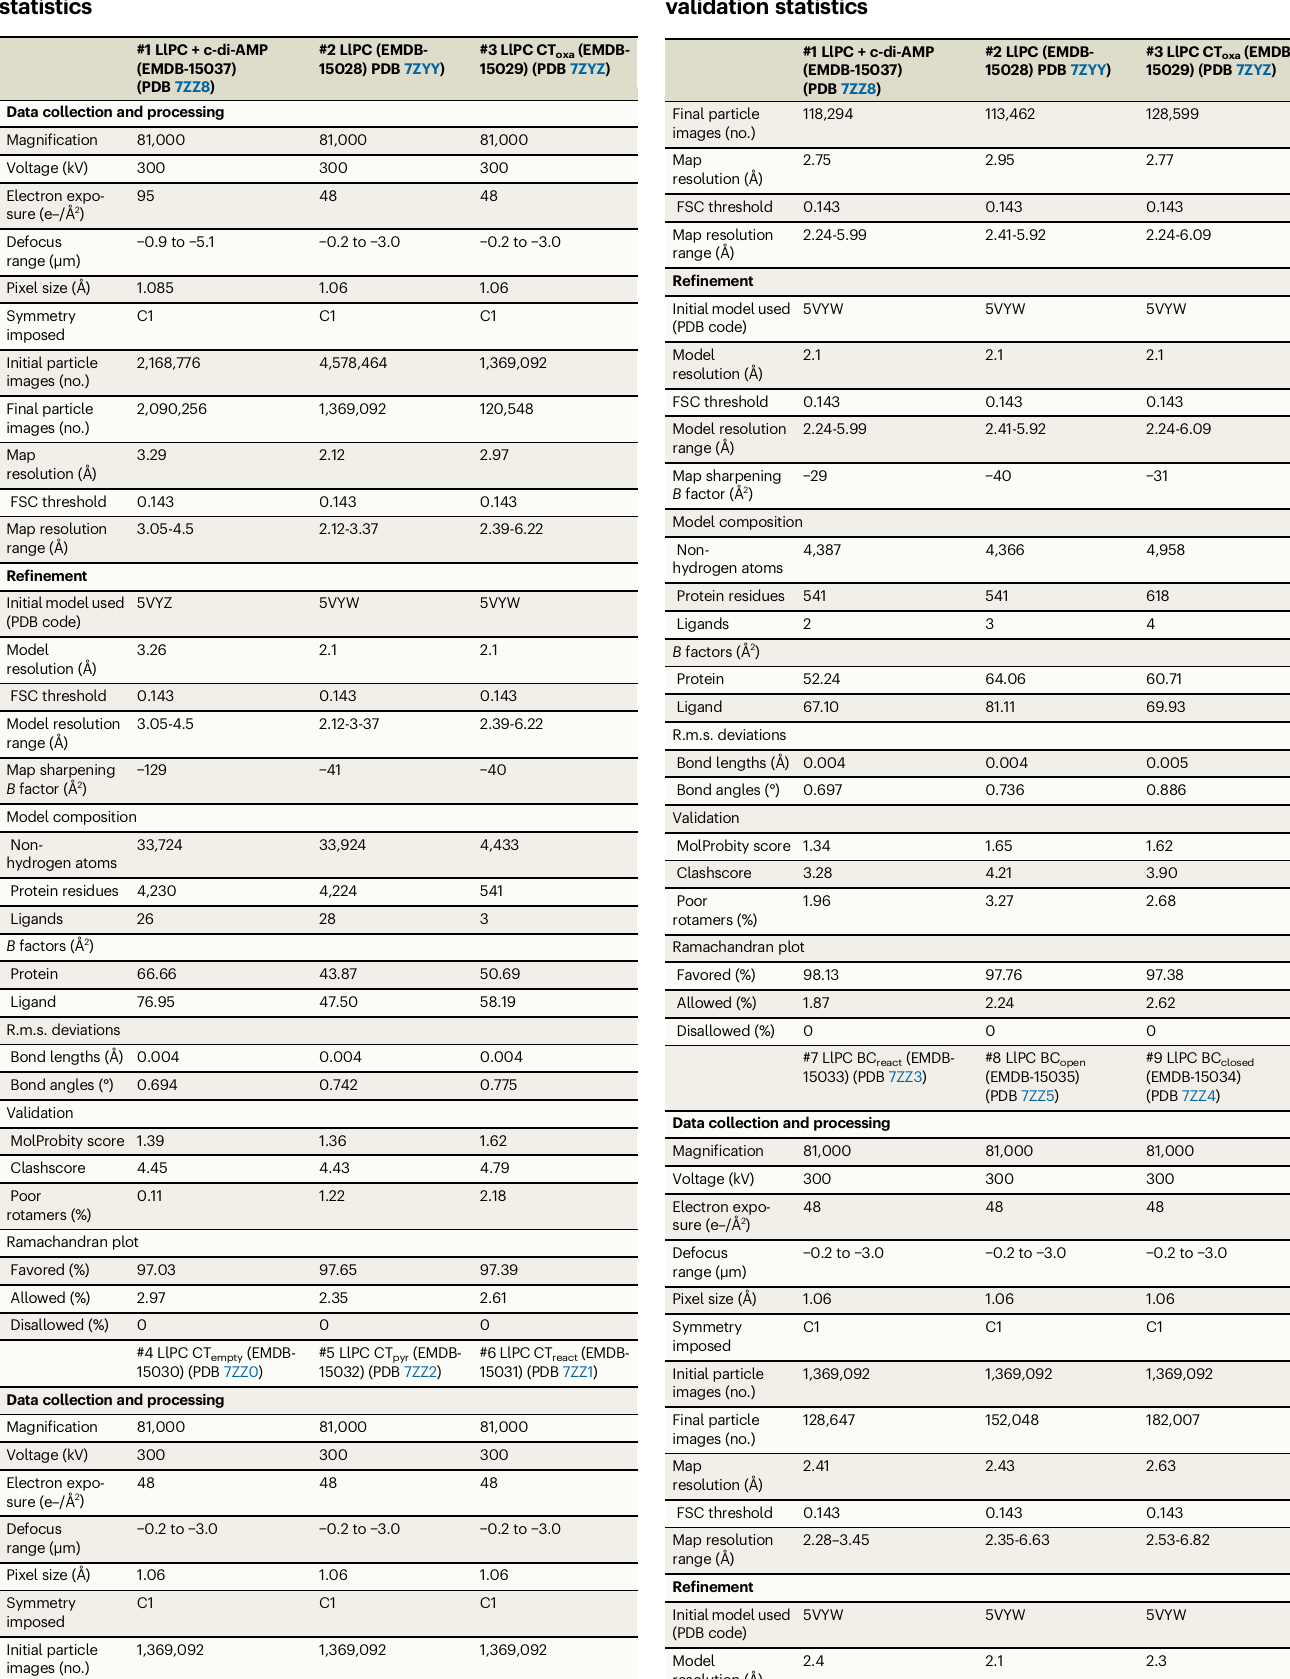
Table 1 | Cryo-EM data collection, re fi nement and validation Table 1 (continued) | Cryo-EM data collection, re fi nement and validation